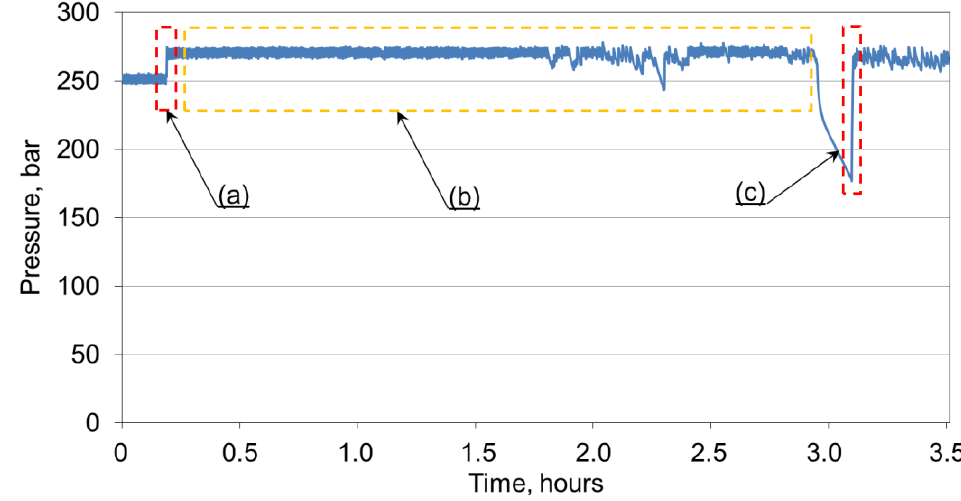
Figure 11. Analysis of the actual load capacity, including the charging function.